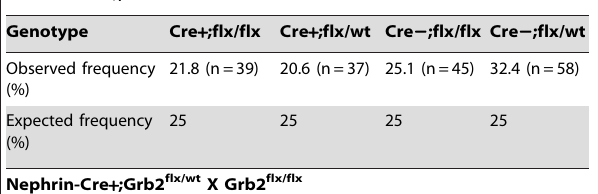
Podocin-Cre + ;Grb2 flx/wt X Grb2 flx/flx Genotype Cre + ;flx/flx Cre + ;flx/wt Cre 2 ;flx/flx Cre 2